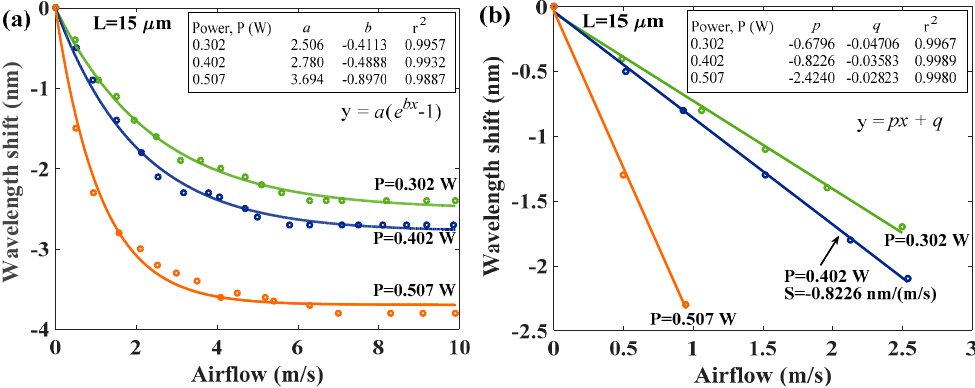
Figure 7. ( a ) Wavelength shifts of interference spectra of 15 μ m HPFFPI under various air fl ows at different input power levels to the chip resistor. ( b ) Wavelength shifts of interference spectra of 15 μ m HPFFPI under different input power levels of the heater.